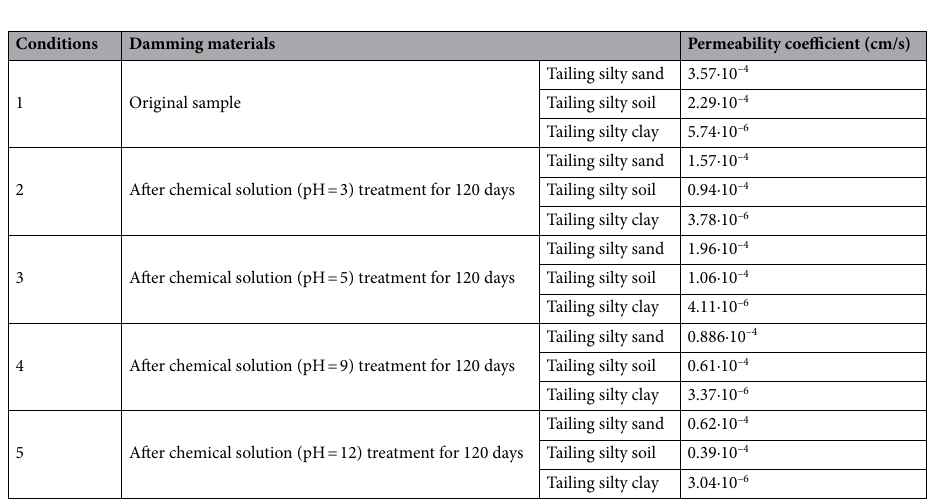
Table 2. Permeability coefficient of various tailings materials under different chemical